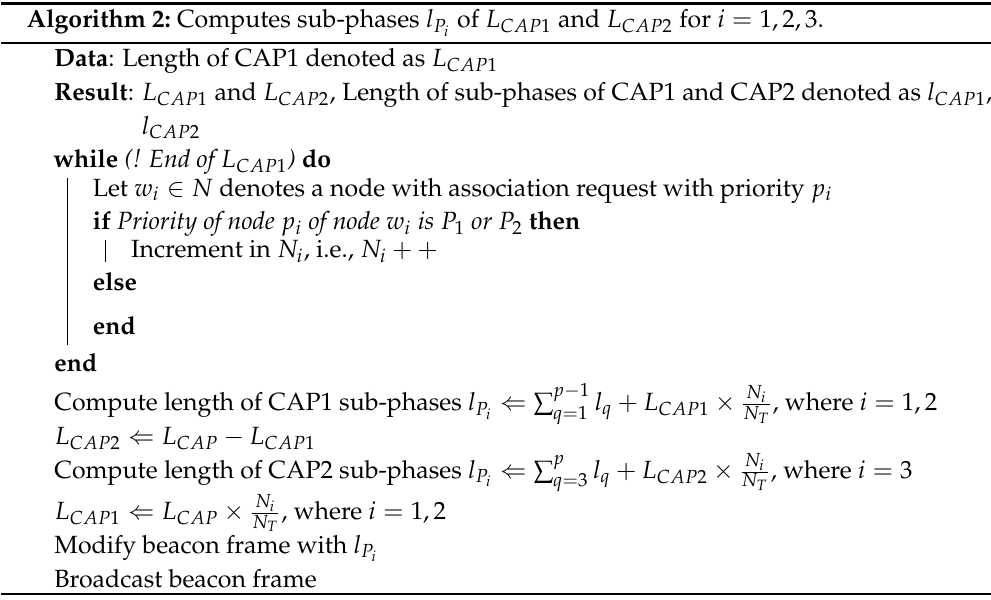
of L CAP 1 and L CAP 2 for i = 1, 2, 3. i